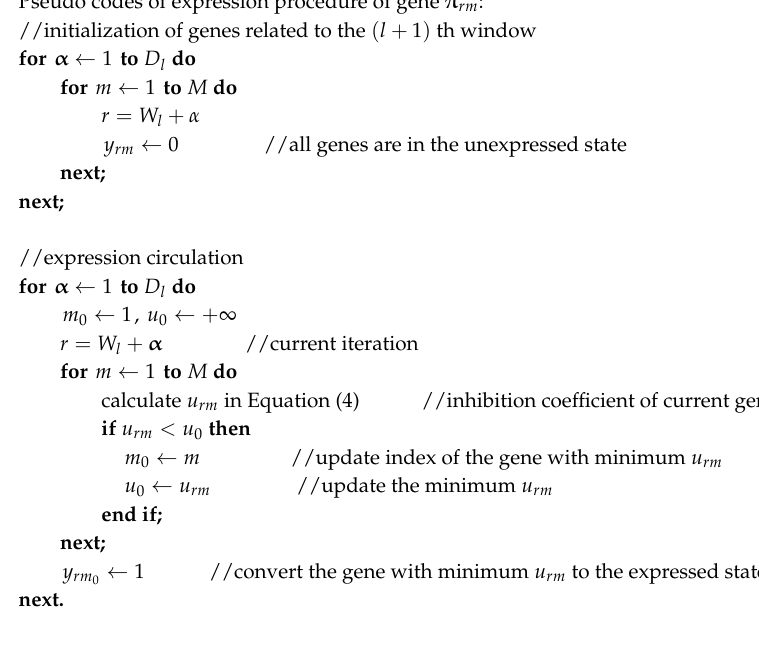
Pseudo codes of expression procedure of gene π rm